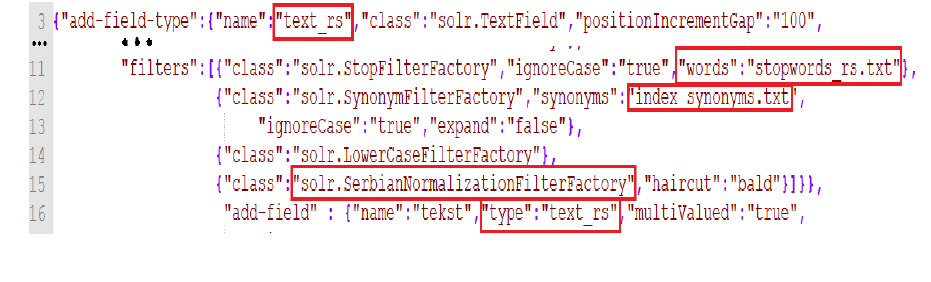
Figure 5 – JSONized request that sets up the Solr server for indexing in Serbian Рис . 5 – Настройка сербского языка на сервере Solr Слика 5 – Подешавање Solr сервера за српски